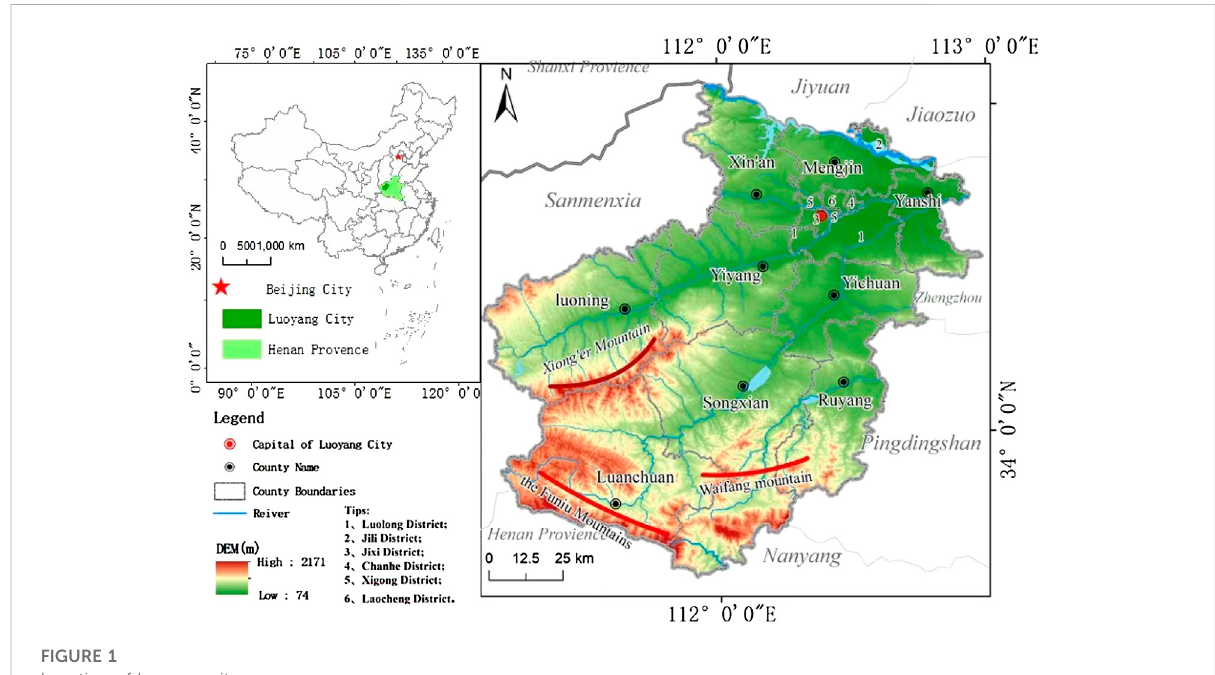
FIGURE 1 Location of Luoyang